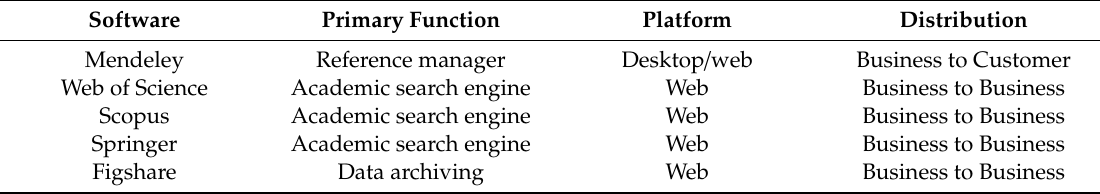
Table 3. Assisting software for the peer-review process taxonomy and function. Software Primary Function Platform Distribution Mendeley Reference manager Desktop / web Business to Customer Web of Science Academic search engine Web Business to Business Scopus Academic search engine Web Business to Business Springer Academic search engine Web Business to Business Figshare Data archiving Web Business to